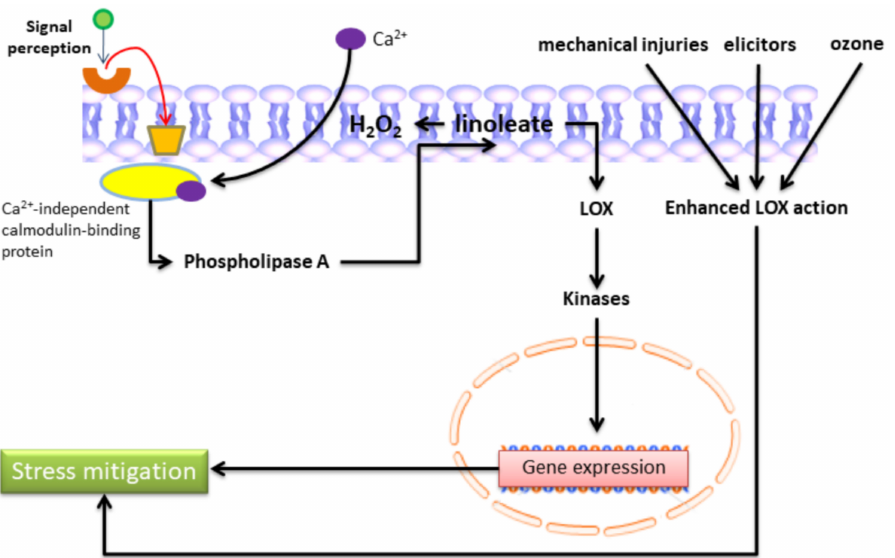
Figure 3. LOX in stress response signaling. The activation of phospholipase A by Ca 2+ and calmod- ulin leads to the release of linoleic and linolenic acids from membrane phospholipids, which are used as substrates by LOXs. Next, hydroperoxidation of fatty acids by LOX can trigger protein kinases and induce the expression of several genes whose products are assumed to be involved in defense